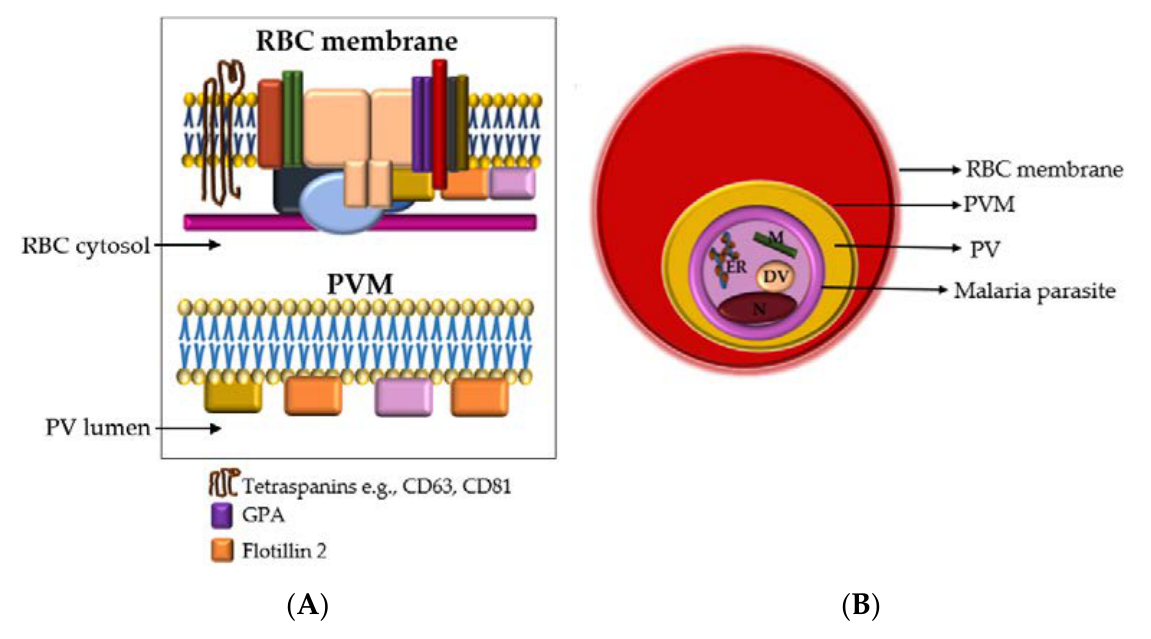
Figure 5. ( A ) Cross-section of the RBC membrane ( top ) and the malaria parasitophorous vacuolar membrane (PVM) ( bottom ). The parasite resides in the RBC cytosol. The parasitophorous vacuole (PV) lumen is the narrow space between the PVM and the parasite membrane (PM). Glycophorin A (GPA) is the major integral protein of the RBC membrane and forms part of the RBC membrane multiprotein complex. Other proteins in this complex that are not specified here are represented by the various shapes and colors and include band 3, spectrin, actin, etc. The malaria parasite PVM is rich in flotillins (1 & 2) but also contains other lipid raft proteins, such as CD55 and CD59 (repre- sented by yellow and pink) ( B ) Within an infected RBC, the malaria parasite resides inside a PV that is encased in a parasitophorous vacuolar membrane. EVs secreted by the parasite would need to pass three membranes: the parasite plasma membrane, the PVM and the RBC membrane. Among